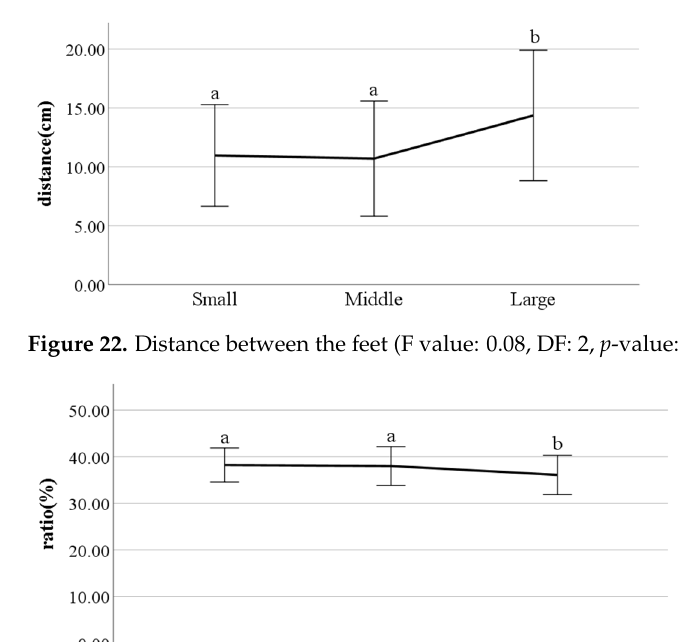
Figure 23. Swing phase of left foot (F value: 4.56, DF: 2, p -value: 0.01).